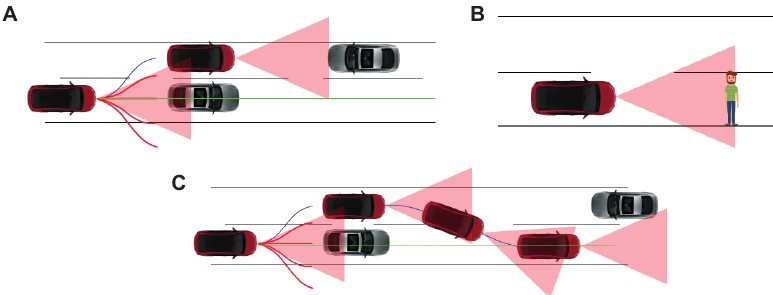
Figure 4. Three example scenarios ( A – C ) with their aerial views.